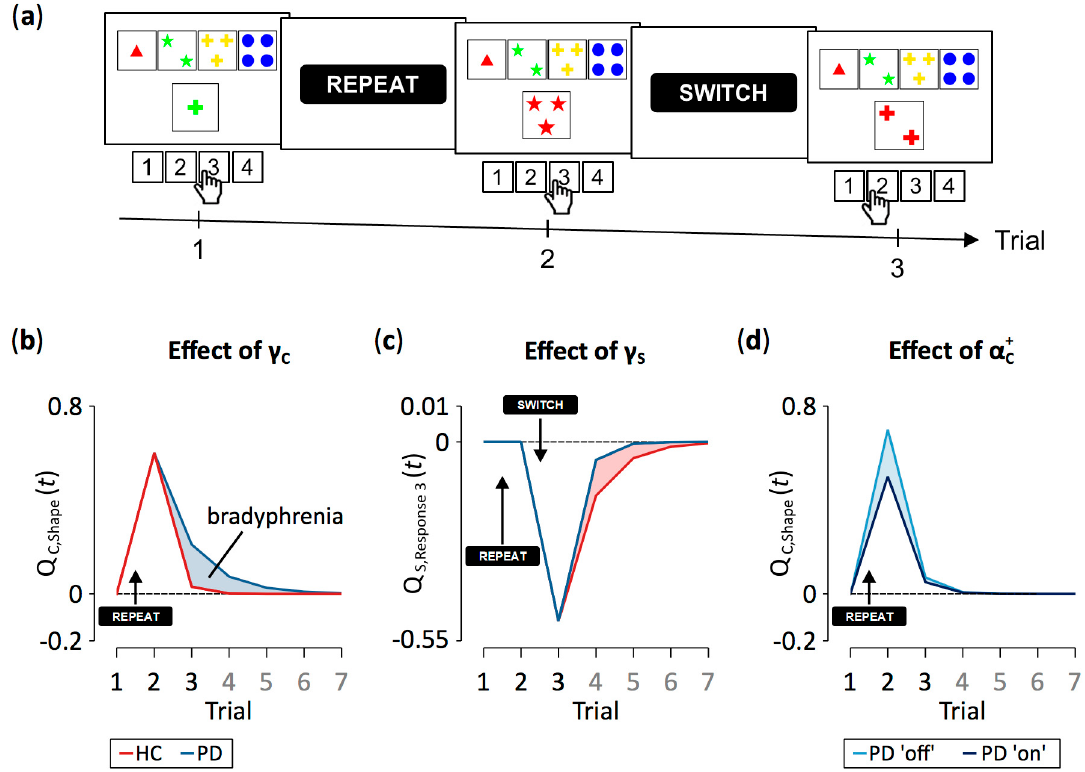
Figure 4. Exemplary e ff ects of between-group variations of model parameters on trial-to-trial dynamics of feedback prediction values. ( a ) The representative trial sequence on the cWCST, as depicted in Figure 1. Panels ( b ), ( c ), and ( d ) give feedback prediction values across seven trials, the first three of them are shown in ( a ). Note that on Trials 4 to 7, neither the shape category was applied nor was response 3 pressed. Panel ( b ) shows cognitive-learning feedback prediction values for the application of the shape category. The received positive feedback on Trial 1 causes an increase in feedback prediction values. With high configurations of the cognitive retention rate (i.e., γ C ), such as seen in Parkinson’s Disease (PD) patients, more information from previous trials (i.e., feedback prediction values) was retained. Panel ( c ) shows sensorimotor-learning feedback prediction values for the execution of response 3. The execution of response 3 was followed by a positive feedback on Trial 1. However, as the sensorimotor learning rate for positive feedback was close to zero, no updating of feedback prediction values happened. On Trial 2, a negative feedback followed the execution of response 3, causing a decrease in feedback prediction values. With low values of the sensorimotor retention rate (i.e., γ S ), such as seen in PD patients, less sensorimotor-learning information from previous trials was retained. Panel ( d ) shows the e ff ect of a low configuration of the cognitive learning rate for positive feedback (i.e., α + ), such as seen in PD patients ‘on’ dopaminergic medication. Low learning rate configurations decrease learning from positive feedback, which is indicated by a reduced amplitude of feedback prediction values. All presented effects of model parameters on trial-to-trial dynamics of feedback prediction values were computed by varying exclusively the parameter of interest at arbitrary values while holding all other model parameters constant.